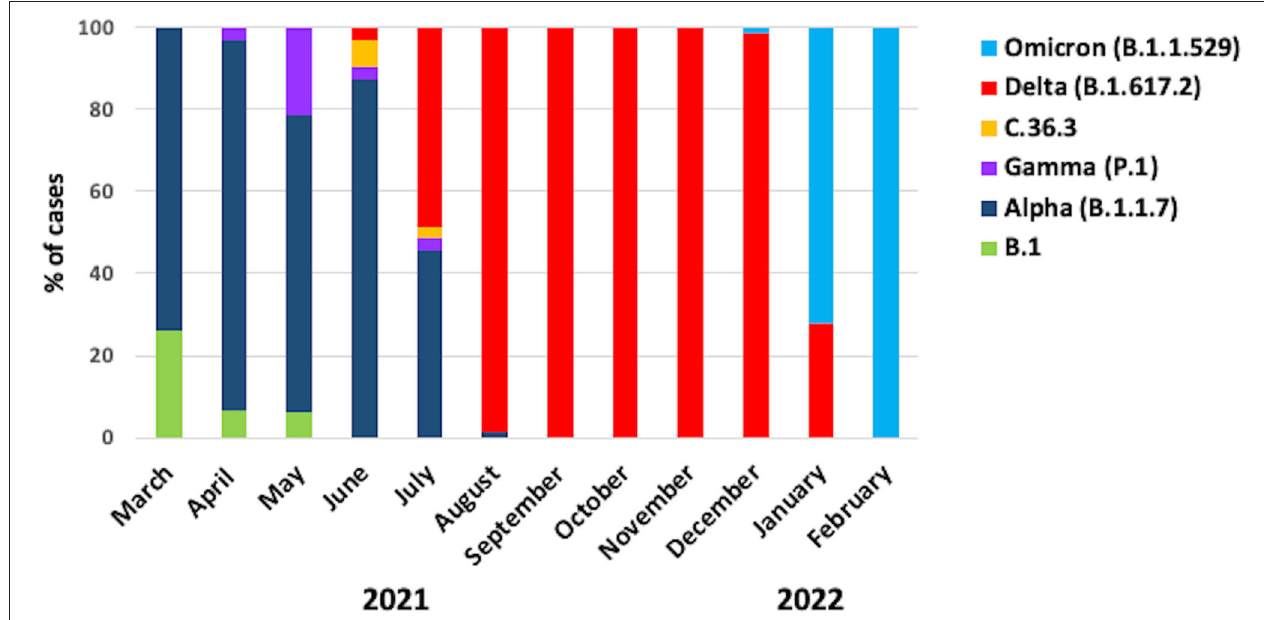
FIGURE 1 | Frequency of the SARS-CoV-2 variants. The graph shows the frequencies of the different variants in the cohort of patients from Regione Calabria in the period between March 2021 and February 2022.